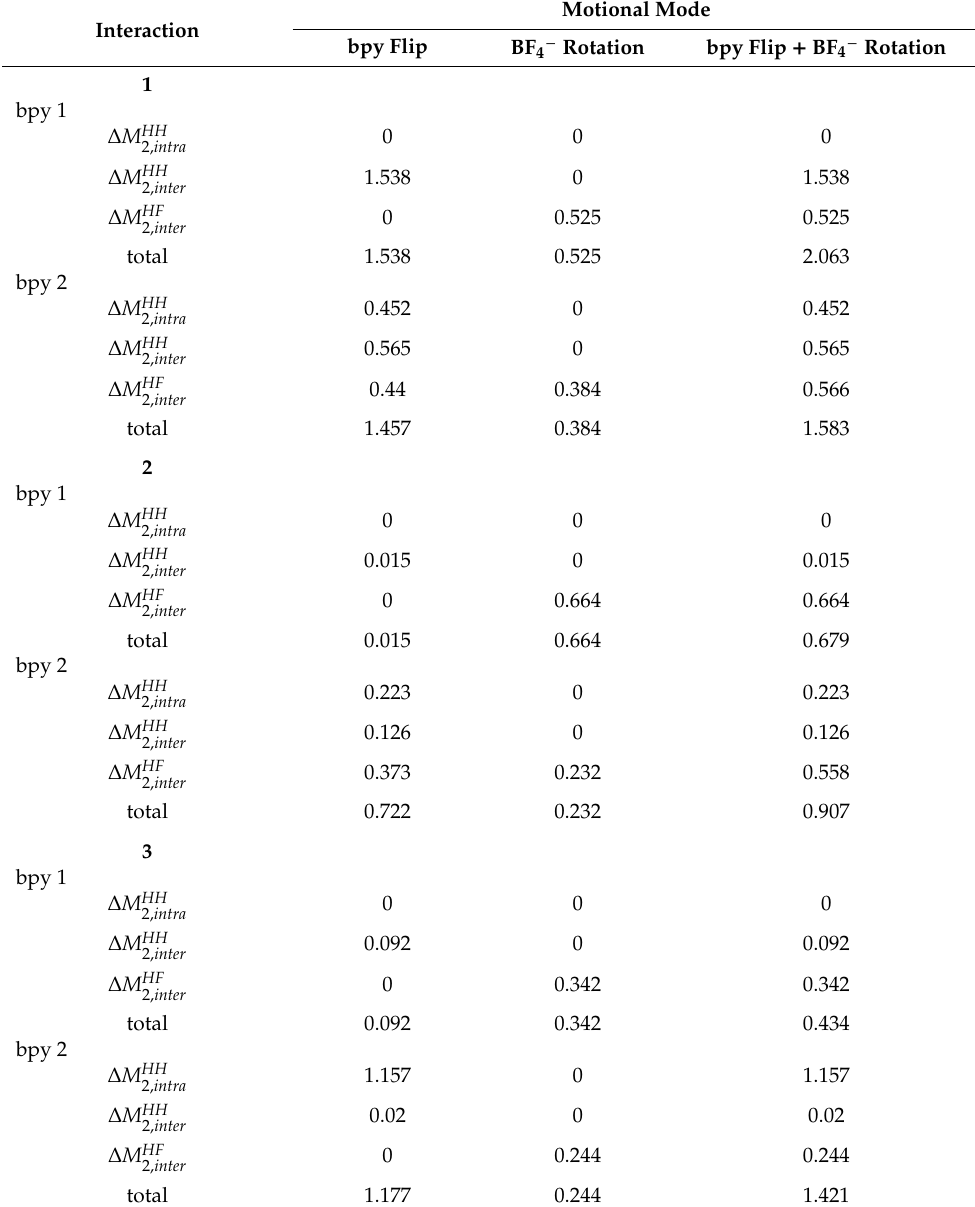
Table 1. Reductions in the 1 H second moments (in 10 − 8 T 2 ) in